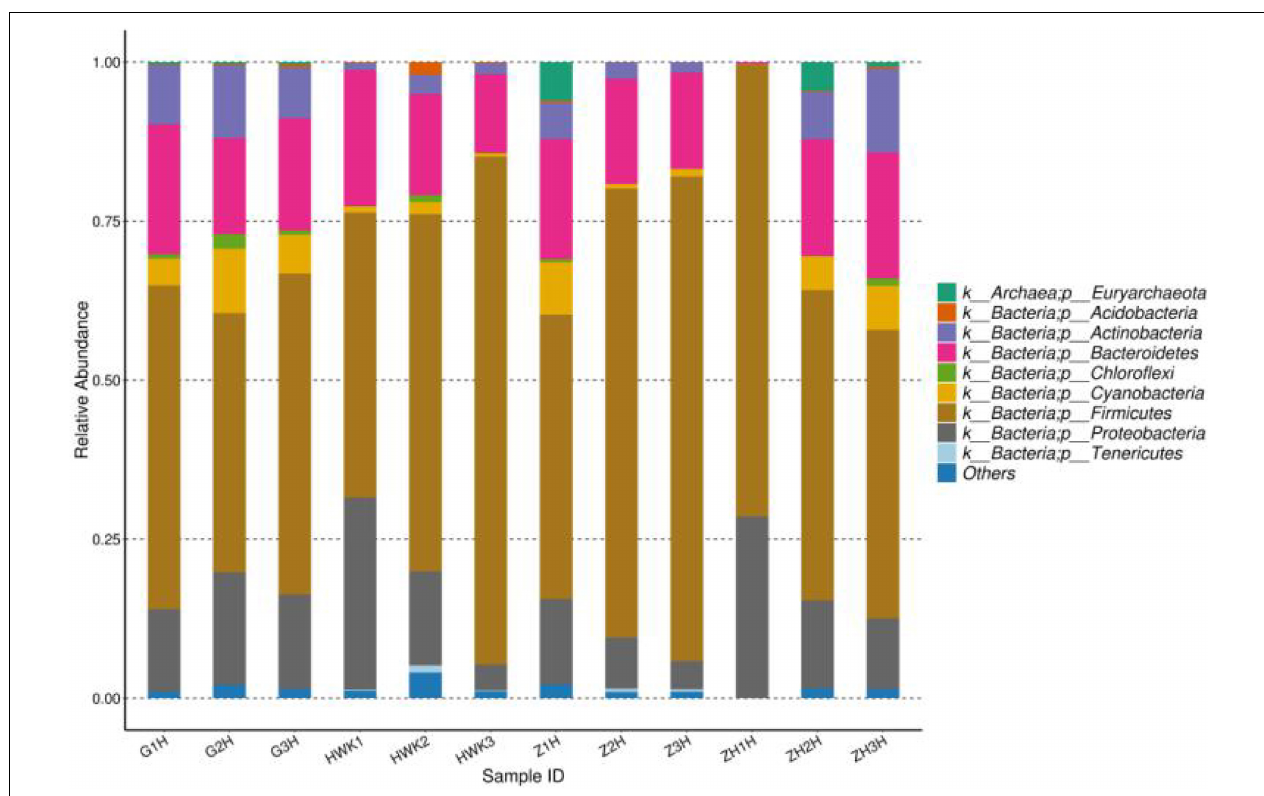
FIGURE 11 | Taxonomic classification of the 16S rRNA sequences at phylum levels. HWK (control group); GH (infection group); ZH (treatment group); ZHH (post-treatment